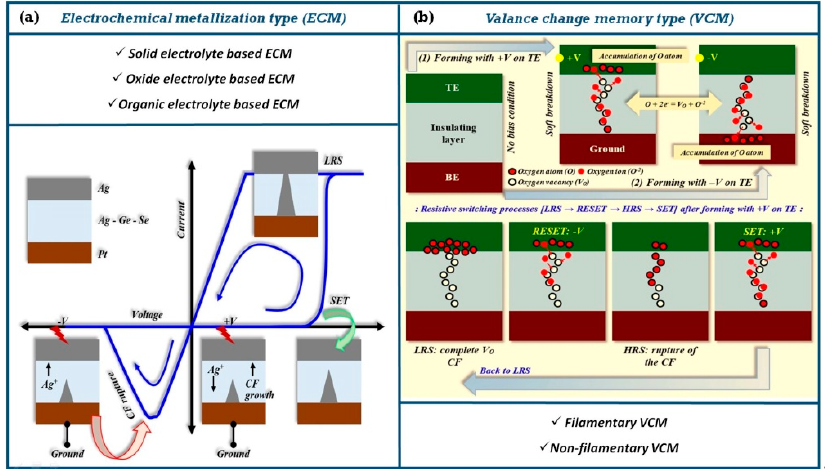
Figure 10. ( a ) Schematic I–V characteristics of electrochemical metallization (ECM) device with switching mechanism in conventional solid-electrolyte-based devices. ( b ) Illustration of the filamentary switching mechanism in VCM devices.